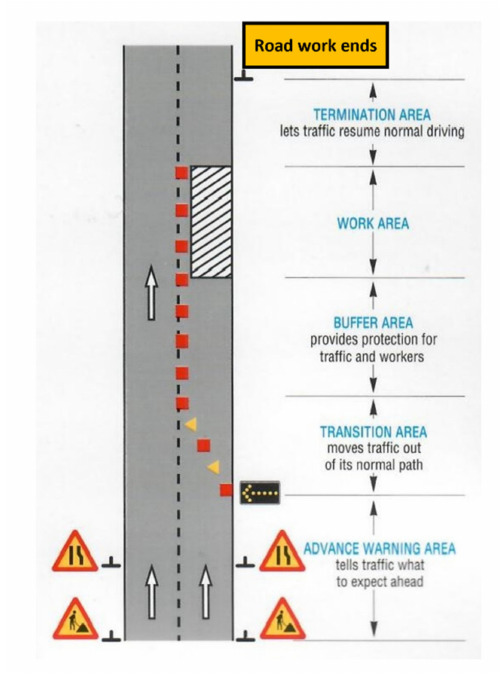
Figure 1. Areas of road work